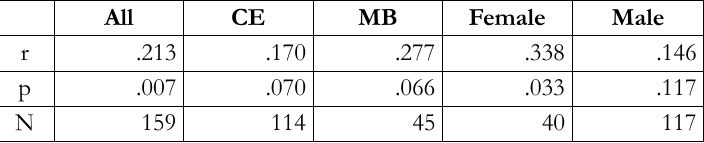
Table 3. Pearson correlation between exam and AAPS scores across